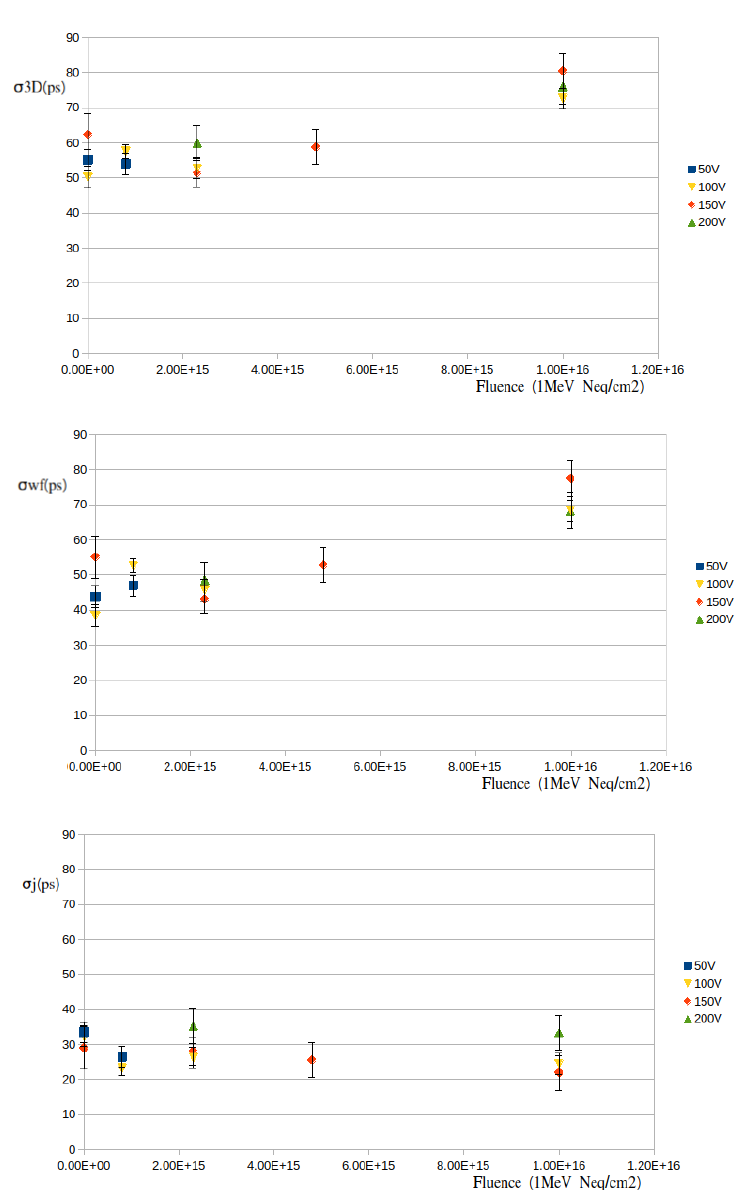
Figure 7. Time resolution vs. fluence for different bias voltages at 20 °C. Top : σ 3 D , middle : σ wf , and bottom : σ j